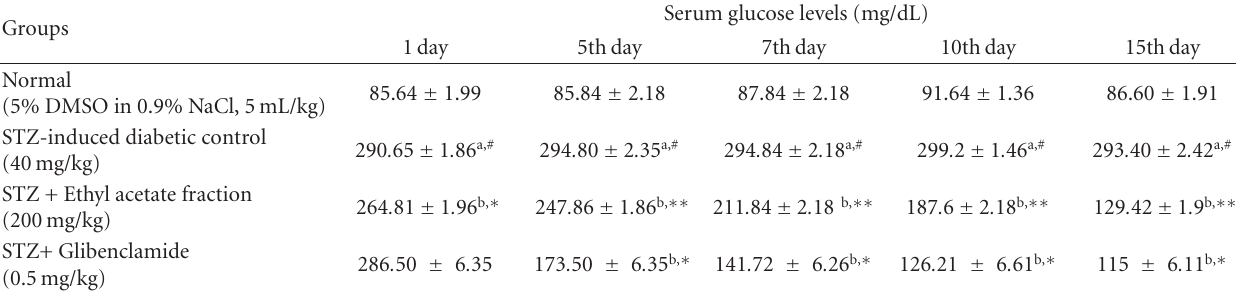
Table 2: E ff ect of ethyl acetate fraction of stereospermum suaveolens on glucose level in STZ-induced diabetic rats. Groups Normal